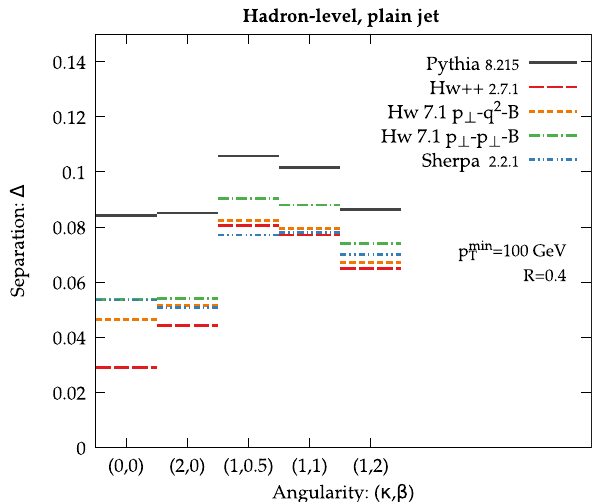
Fig. 16 Classifier separation (cid:12) for the five angularities, determined from the various generators at hadron level in the case of quark/gluon tagging at the LHC (see Sect. 6 of [9] for details). The first two columns correspond to IRC-unsafe distributions (multiplicity and p D last three columns are the IRC-safe